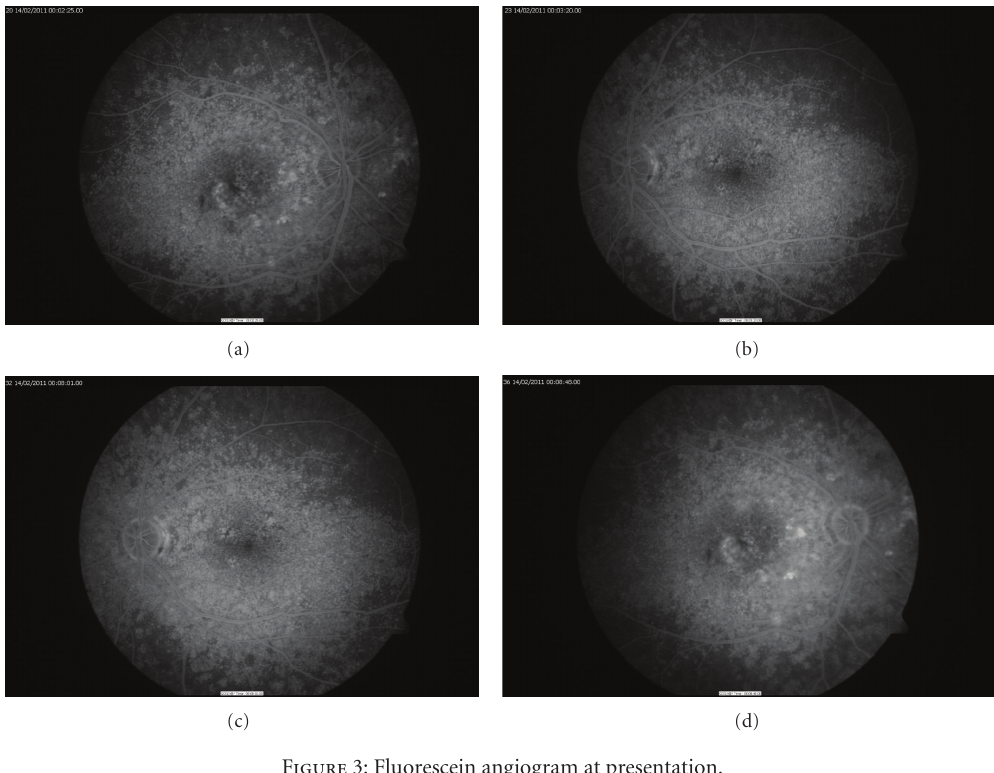
Figure 3: Fluorescein angiogram at